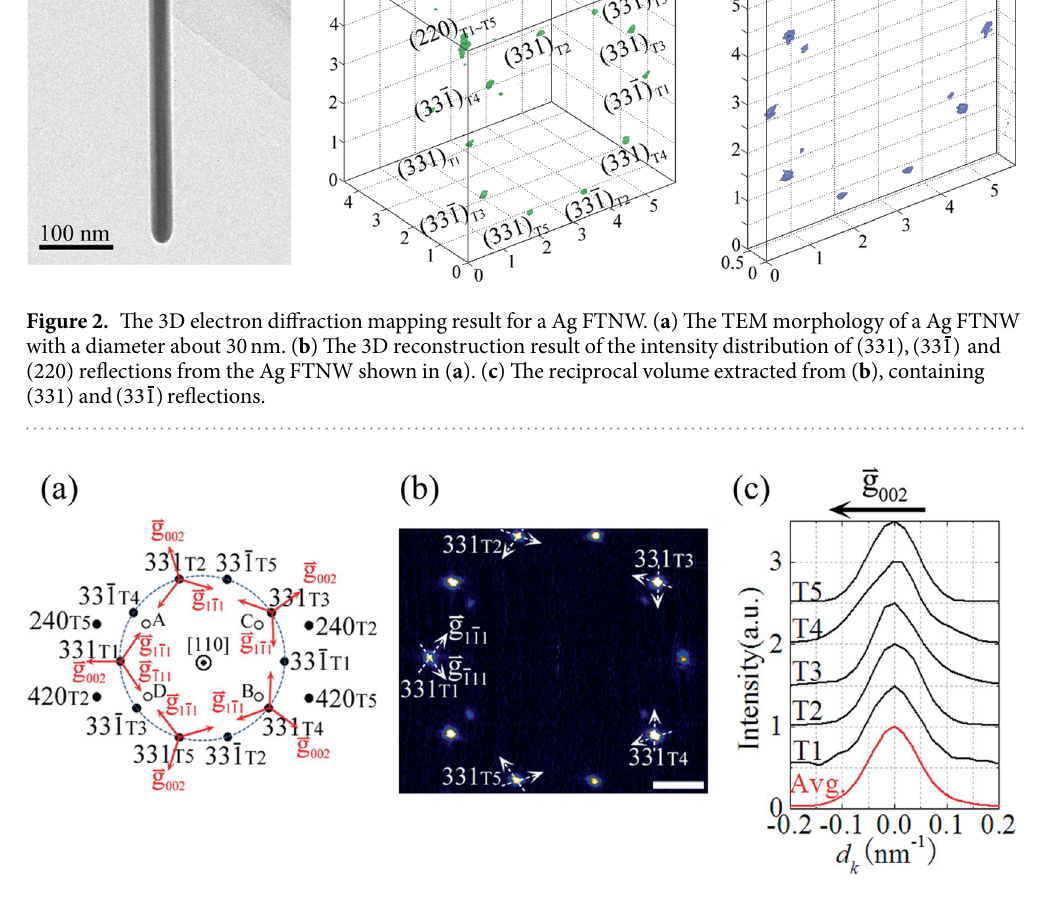
Figure 3. The experimental 2D intensity distribution of (331) and (331) reflection. ( a ) The pictorial demonstration drawing of the reciprocal-space cross-sectional plane of Ω, cutting through the diffraction centers of (331) and (331) reflection. The orientation of each single crystalline segment is represented using the    reciprocal vectors, , and , indicated by red arrows. The filled circles indicate the first order diffraction g g g 002 111 111 centers, the hollow circles represent the double reflections which are due to the (240) T2 (or (420) T2 ) diffracted beam rediffracted by the (002) T1 planes of T1 segment (the spots labelled as A and B), or attributed to it that the incident beam travelling through T1 segment is firstly diffracted by (002) T1 planes and then the diffracted beam passes T5 segment and is rediffracted by (240) T5 (or (240) T5 ) planes (the spots labelled as C and D). ( b ) The experimental 2D intensity distribution of the (331) and (331) reflections in the Ω plane. The scale bar is 1 nm − 1 . In the inner circle, the four weak spots are double reflections as schematically shown in ( a ), the labelled spots of A, B, C and D. ( c ) The intensity profiles for five single crystalline segments (T1~T5) along the direction parallel  to vector extracted from ( b ). The five intensity curves are normalized and vertically offset. The average g 002  curve (Avg.) of the five g experimental intensity profiles is displayed at the 002 state and the internal defects. To further investigate the internal structure and the cross-sectional strain distribu- tion of the Ag FTNW, the 2D intensity distribution of (331) and (331) reflections in the Ω plane has been extracted from the reconstructed 3D reciprocal volume [Fig. 2(c)] and represented in Fig. 3(b). In order to reduce the noise, the 2D intensity map shown in Fig. 3(b) is an axial integration about the reflection center with integration width of about 0.18 nm − 1 along [110] axial direction. Considering the ideal case of the single crystalline segment which is infinitely long and without internal strain and defects [Fig. 4(a)], the (331) intensity distribution in Ω plane has been simulated by kinematic electron diffraction as shown in Fig. 4(c). The characteristic ‘flare’ seen is due to shape-induced broadening of the reflection and reflects the triangular cross-sectional morphology of the single crystalline segment as schematically shown in the left part of Fig. 4(a). In this strain-free state, the simulated 2D intensity map of (331) reflection shows an inversion (180° rotation) symmetry. However, such a symmetric fea- ture cannot be observed in the reconstructed 2D intensity map [Fig. 3(b)] of (331) reflections diffracted by T1~T5 single crystallites of the Ag FTNW under study. We believe that such asymmetry of the experimental intensity